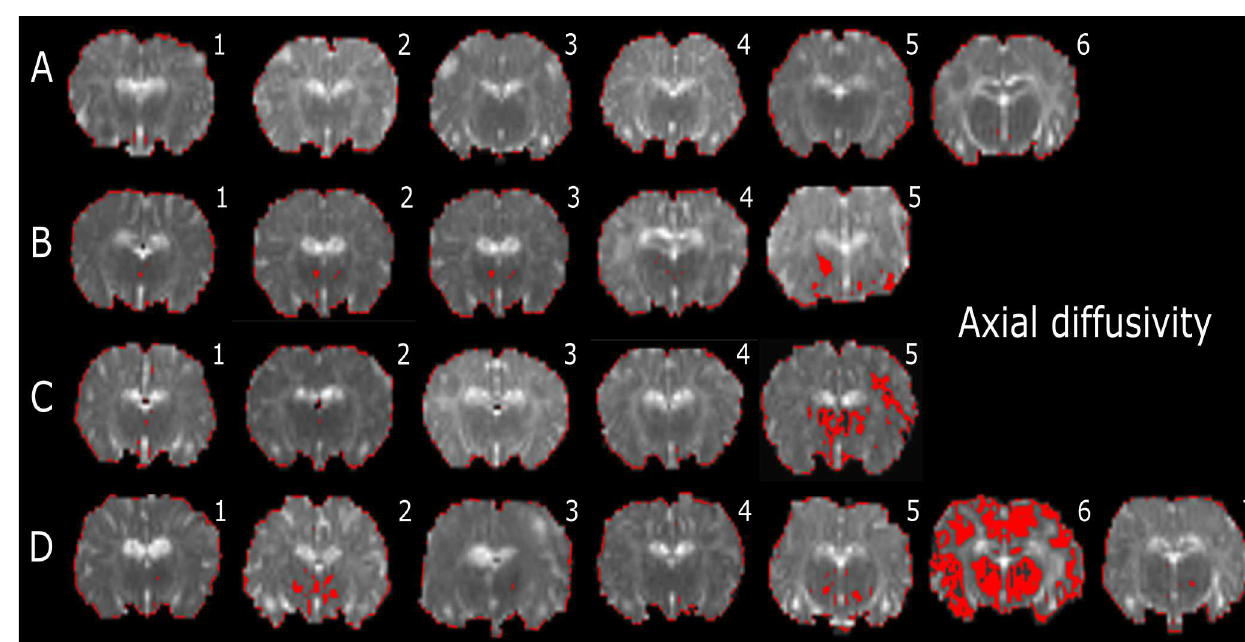
Fig 4. Representative slicesof whole-brain DTI colour mapsof the thalamus(Th) for axialdiffusivity (AD). Voxeldiffusivityintensitiesfalling belowthe lowthreshold are shownas red for AD measurementsfor all lambbrains.All low-diffusionmapsareoverlaidon diffusionimagesfor a slice passingthroughthe thalamus(Th). In the injuriousventilation(INJ n = 5; C) andumbilicalcord occlusion(INJ+UCOn = 7; D) groups,red indicates lowervaluesin the rangeof the threshold, whileblackindicates valuesbelowthe threshold(seeexplanation in S2 Fig).One shamsurgery(Sham n = 5; B), oneINJ, andthree INJ+UCOlambshadwidespread lowerdiffusivityvaluesin the Th thanunoperatedcontrollambs(Contn = 6; A).